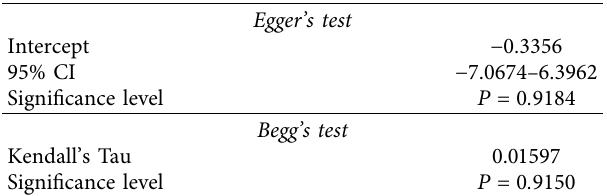
Table 8: Publication bias for the study related to the prevalence of human